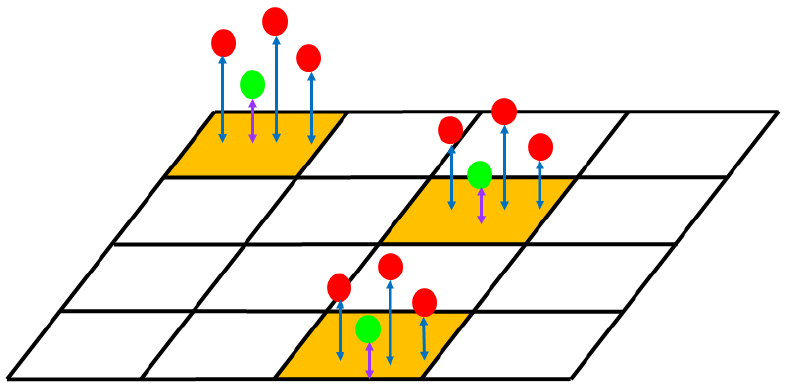
Figure 3. Scheme of the assigned points to the DTM cells. In each cell, the minimum assigned point in height (the green dots) is selected as the ground representative at that